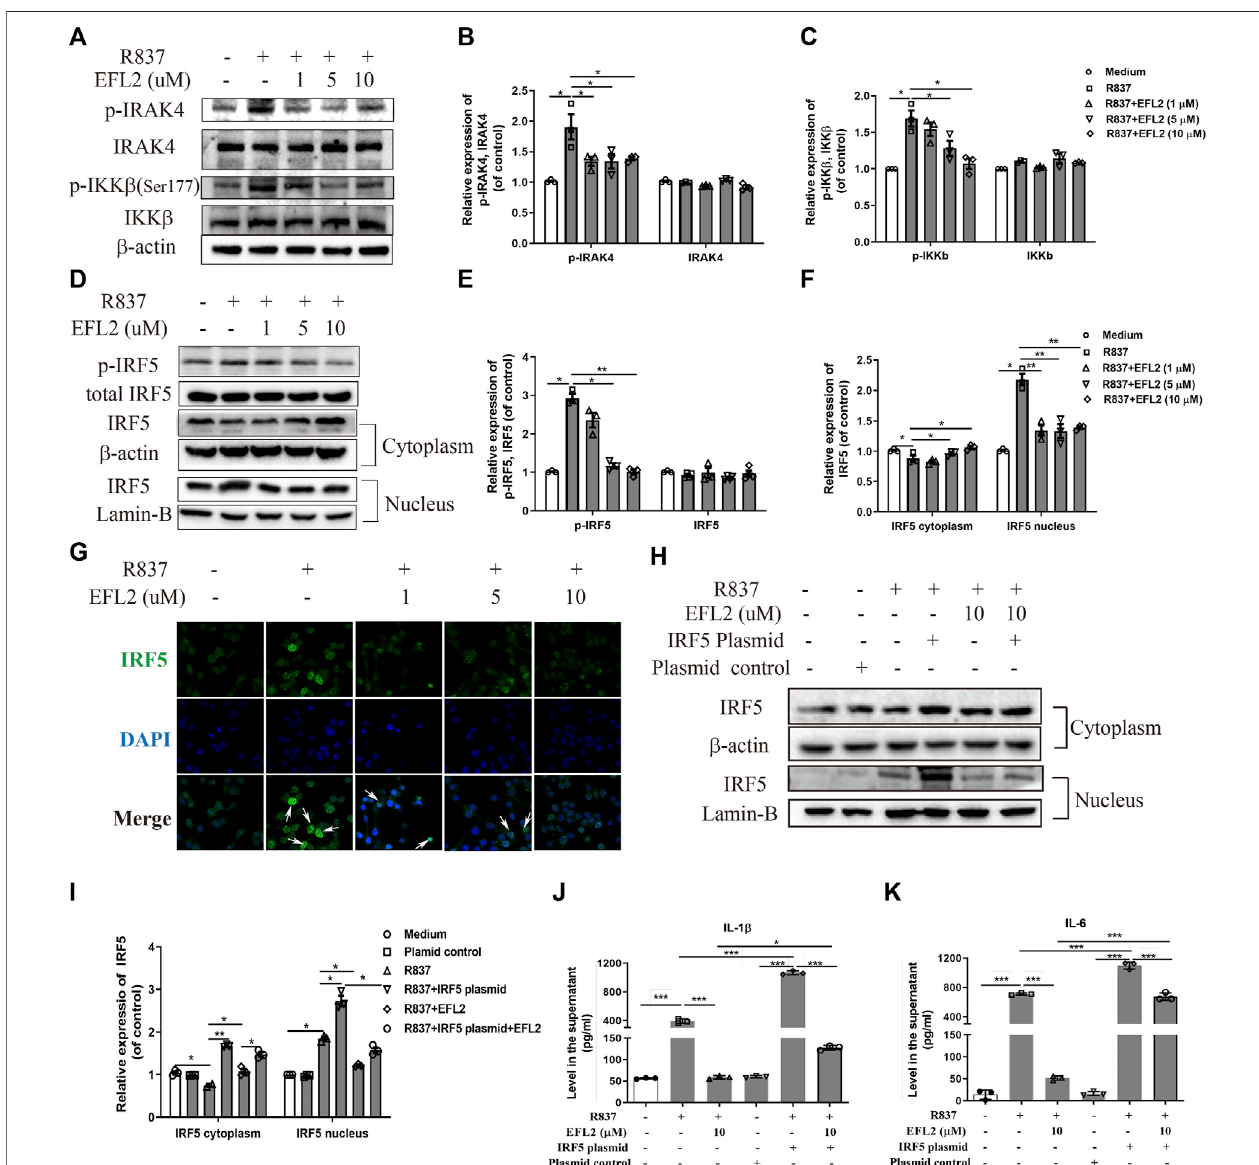
FIGURE 5 | EFL2 reduced IL-1 β and IL-6 production via robustly inhibiting TLR7-IKK β -IRF5 signalling pathway (A-C) Western blot bands (A) and quanti fi cation of p -IRAK4, IRAK4 (B) , p -IKK β and IKK β expression (C) in RAW264.7 cells (D-F) Western blot bands (D) and effects of EFL2 on R837-induced IRF5 phosphorylation (E) and IRF5 expression in cytoplasm and nucleus (F) (G) IRF5 localization determined by immuno fl uorescence staining (Magni fi cation: × 40) (H) IRF5 expression in cytoplasm and nucleus after IRF5 overexpression (I) Quanti fi cation of IRF5 expression after transfection (J, K) The levels of IL-1 β (J) and IL-6 (K) produced by RAW264.7 cells before and after IRF5 overexpression(n (cid:1) 3for each group inan independentexperiment). Datarepresent the mean values ± SEMof three independent experiments. * p < 0.05, ** p < 0.01, *** p < 0.001 were considered as signi fi cant.